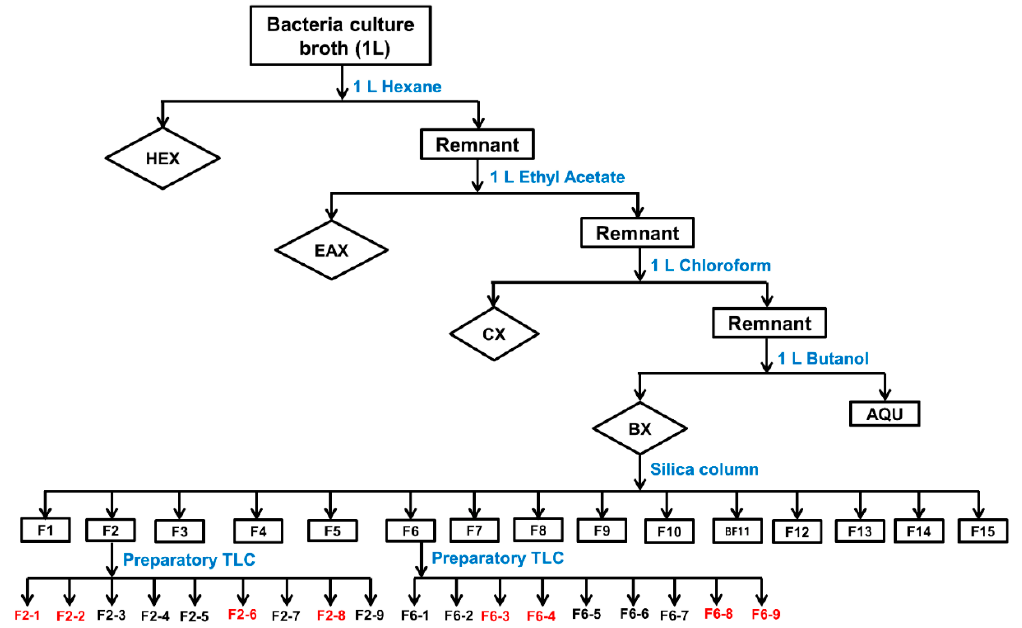
Figure 1. A diagram illustrating fractionation steps of culture broth of Xenorhabdus hominickii . Organic extracts were collected from hexane (HEX), ethyl acetate (EAX), chloroform (CX), and butanol (BX) organic solvents. The butanol extract was separated using a chromatography column filled with silica gel where a gradient chloroform / methanol mixture with increasing amount of methanol from 100:0 to 0:100 ( v / v ) was used. The active butanol fractions (F2 and F6) were further separated using preparatory thin-layer chromatography (TLC).